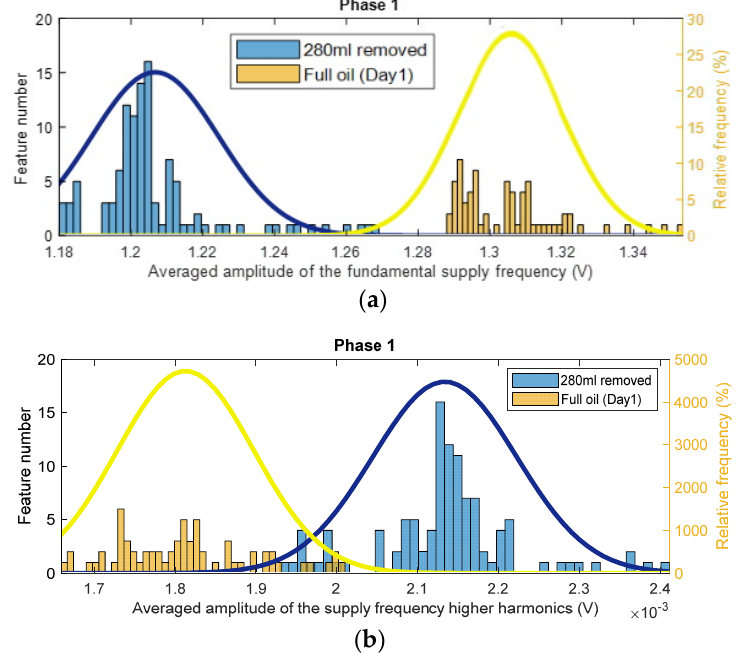
Figure 13. ( a ) Histograms of the average magnitude of the fundamental harmonic of the supply frequency; and ( b ) histograms of the average magnitude of the higher harmonics of the supply frequency. Data are corresponding to the standard oil level for Day1 and to 280 mL of the removed oil (20 kg load, phase 1).